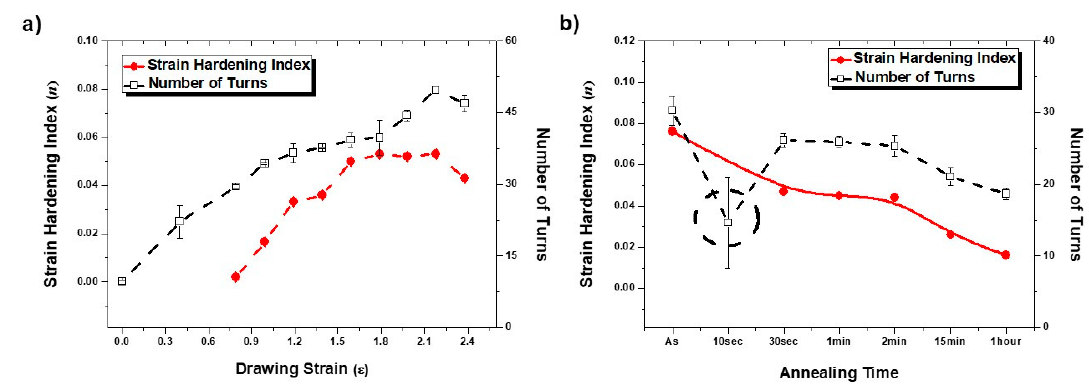
Figure 7. The variations of strain-hardening index and NT ( a ) with drawing strain in steel wires and ( b ) with annealing time at 500 °C in steel wires cold drawn with a strain of 1.95.